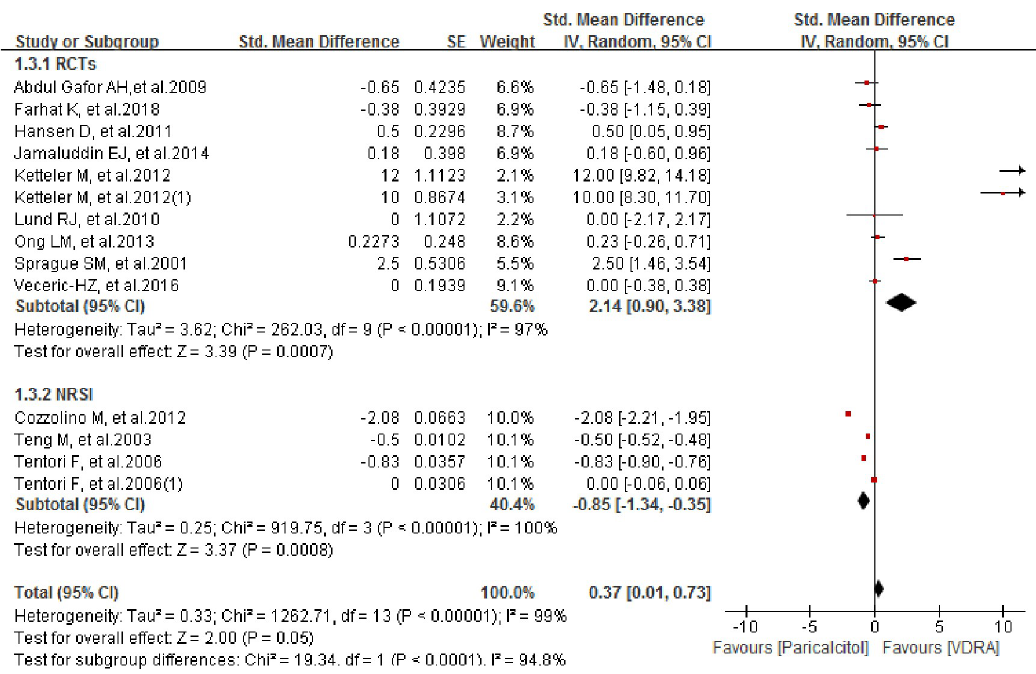
Fig 6. Forest plot of comparison between paricalcitol and VDRA regarding to serum calcium level.